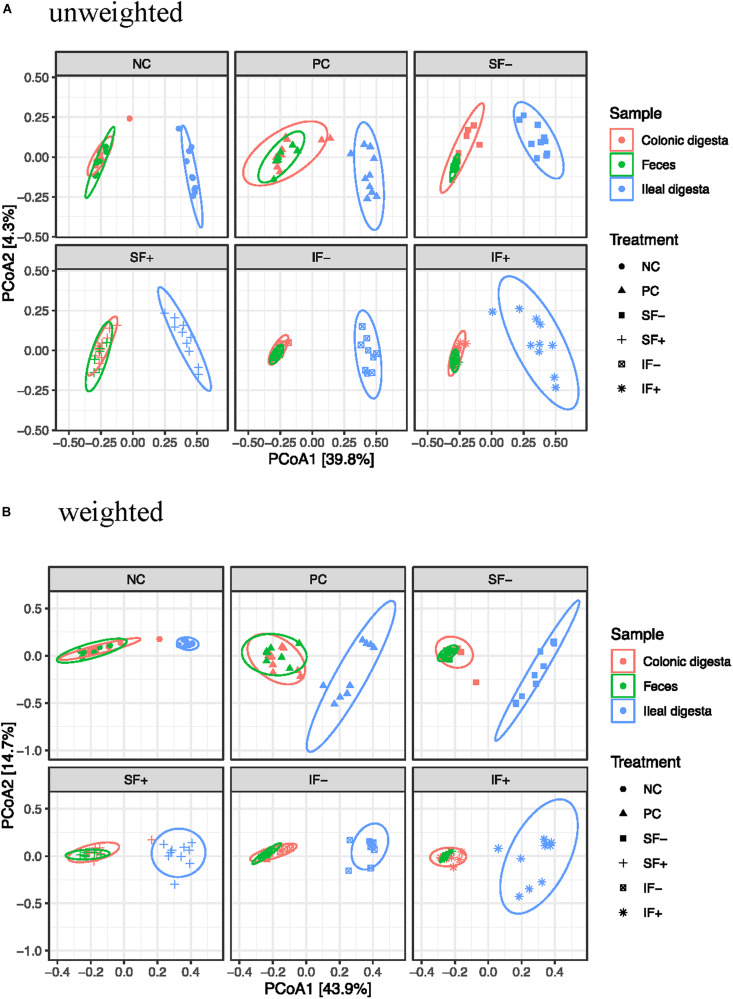
Principal coordinates analysis (PCoA) score plot of ileal, colonic, fecal samples. (A) Unweighted UniFrac distances. (B) Weighted UniFrac distances; NC, non-challenged control diet; PC, ETEC-challenged control diet; SF-, soluble fiber without carbohydrases; SF+, soluble fiber with carbohydrases; IF-, insoluble fiber without carbohydrases; IF+, insoluble fiber with carbohydrases.